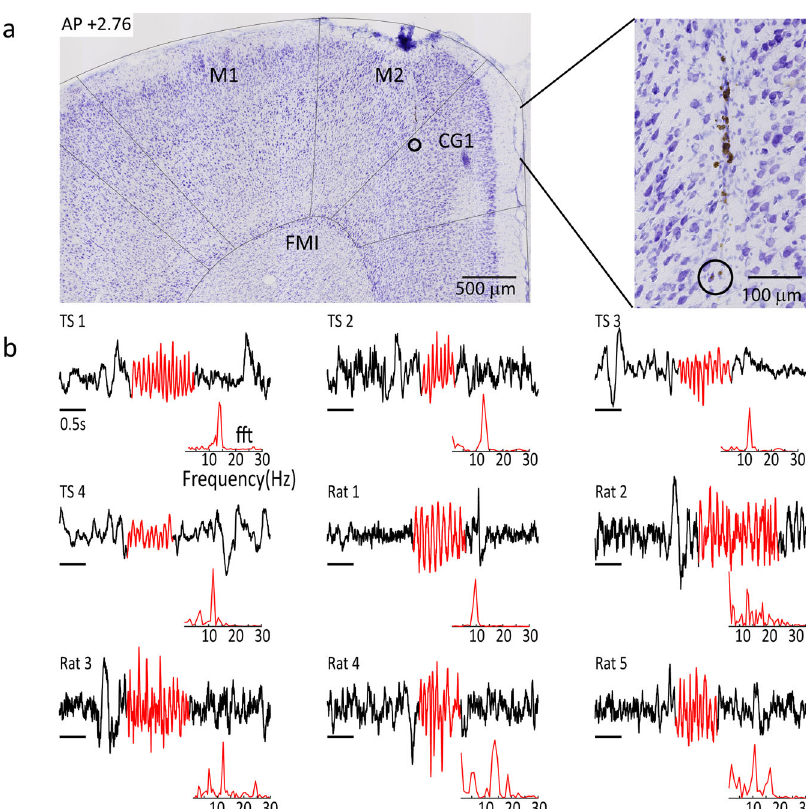
Fig. 6 Validation of recording site and spindle selection. a Nissl stained section taken ~2.76 mm anterior to bregma from an example rat, showing electrode track and recording site (open circle). b Un fi ltered epochs showing examples of spindles detected for each tree shrews and each rat. Red shaded areas indicate the detected spindle, insets below show the fast Fourier transform (fft) of the detected spindle between 5 and 30 Hz. Cg1 anterior cingulate cortex, M1 primary motor cortex, M2 secondary motor cortex, FMI forceps minor corpus